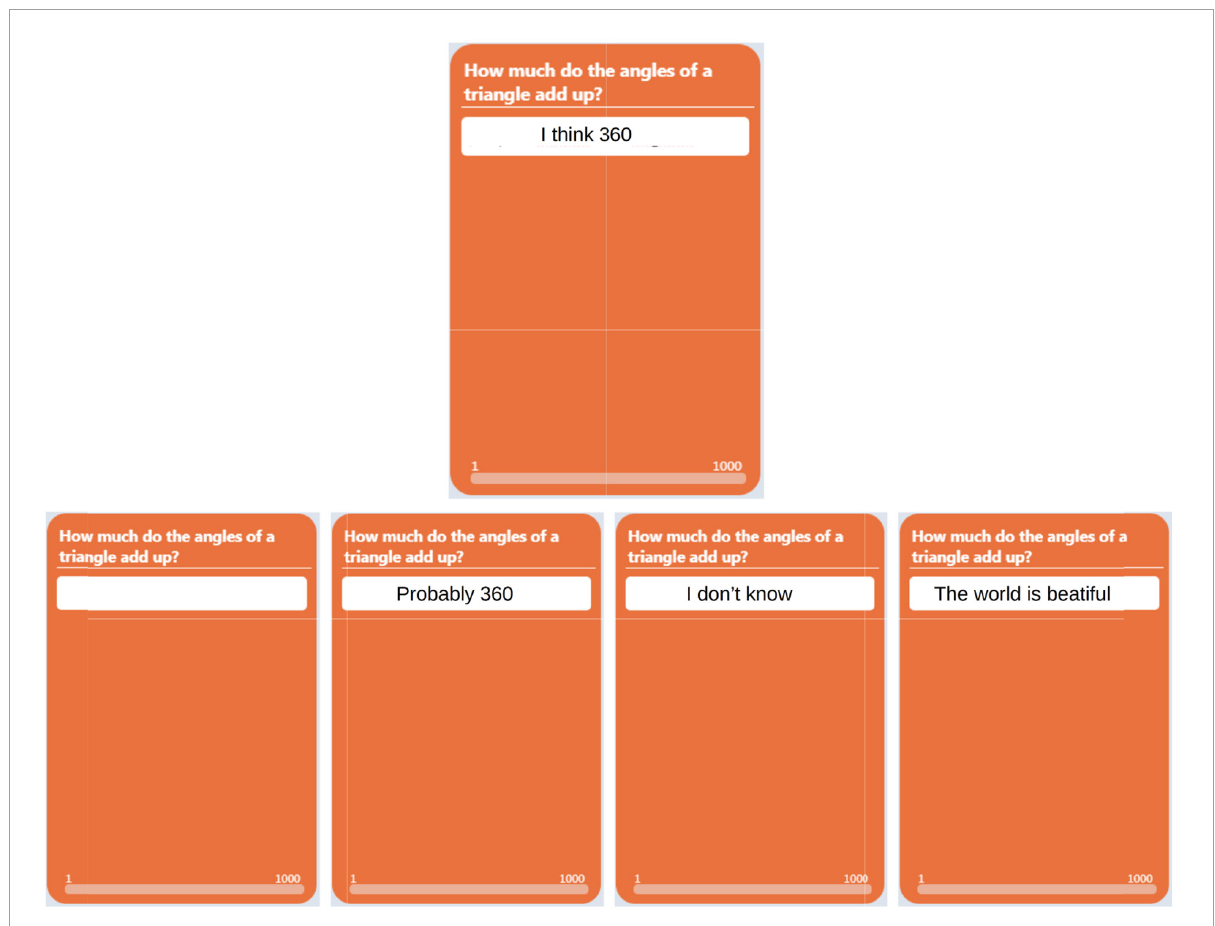
FIGURE2 Scheme of online platform view (Phase 2) from the viewpoint of one student (upper position). He/she can see his/her four neighbors (lower position). Used with permission from Kampal Data Solutions.